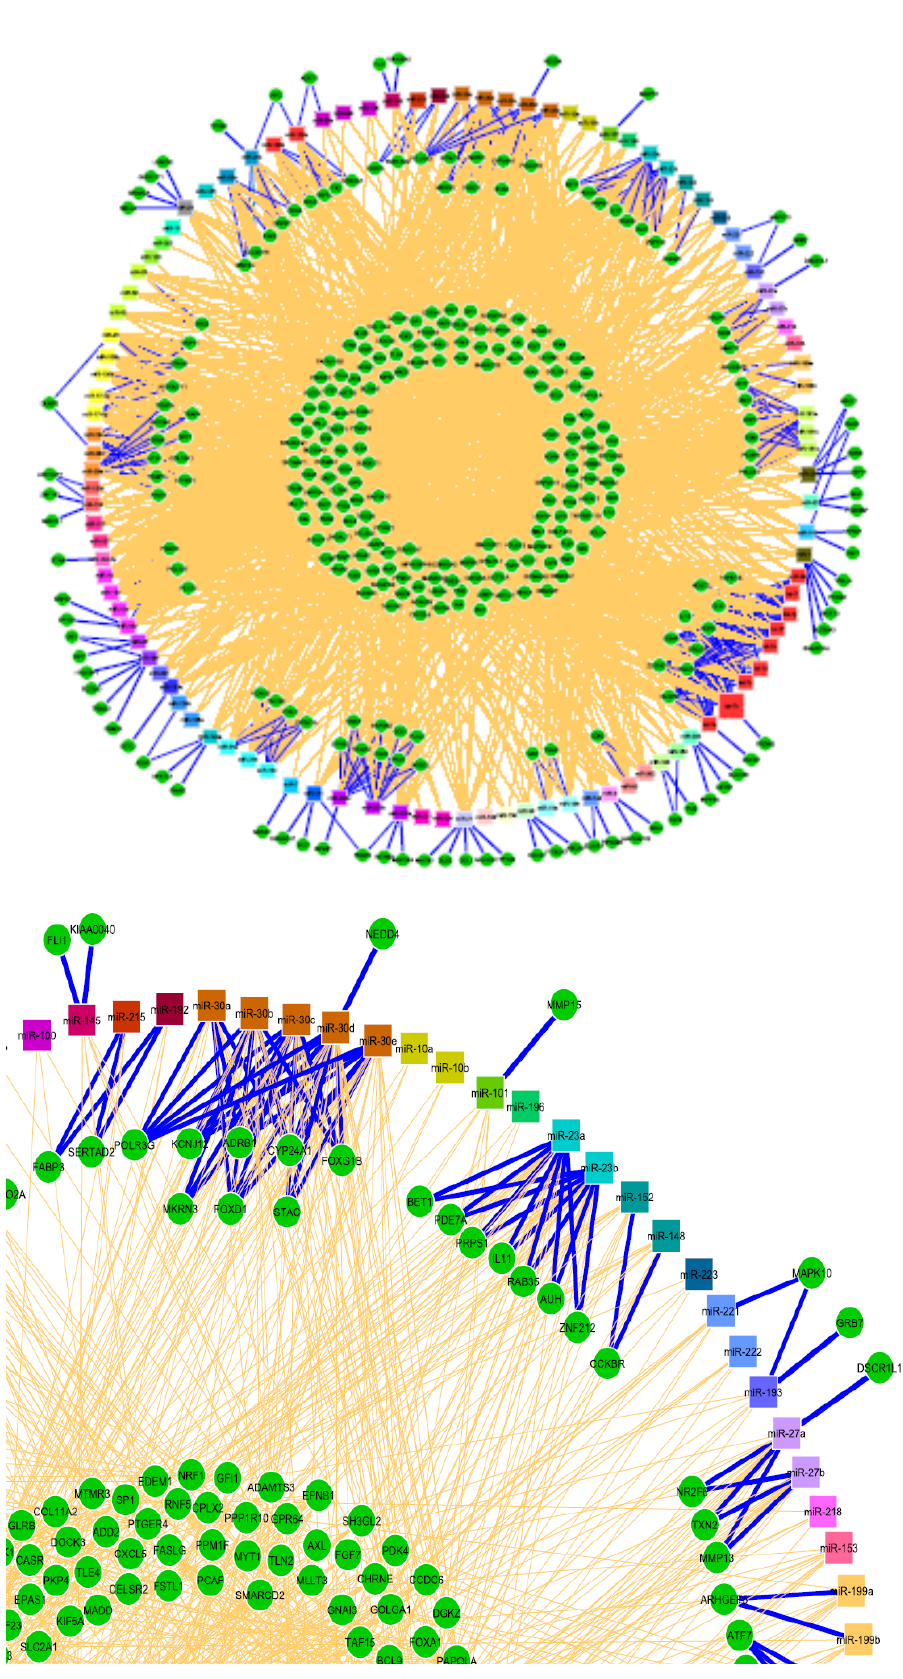
Figure 3. Partial illustration highlighting the complex network of interaction between microRNAs and their target genes including negative feedback mechanisms. Reprinted with permission from “Using Expression Profiling Data to Identify Human MicroRNA Targets” using GenMiR ++ data analysis algorithm ( Nat. Methods 2007 ).